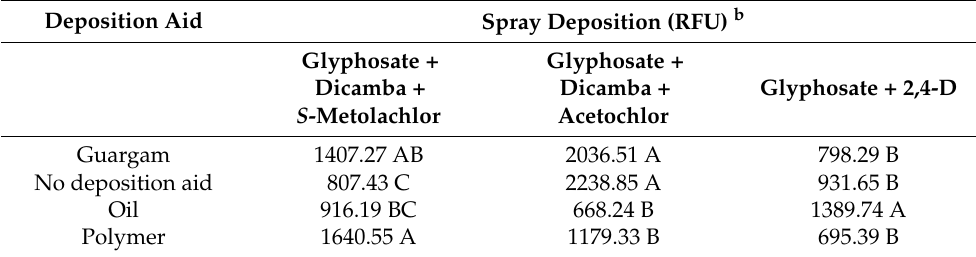
Table 4. Cotton spray deposition a of herbicide solutions tank-mixed with different deposition aids. Data were pooled over years. Means within a column followed by the same letter are not significantly different ( α ≤